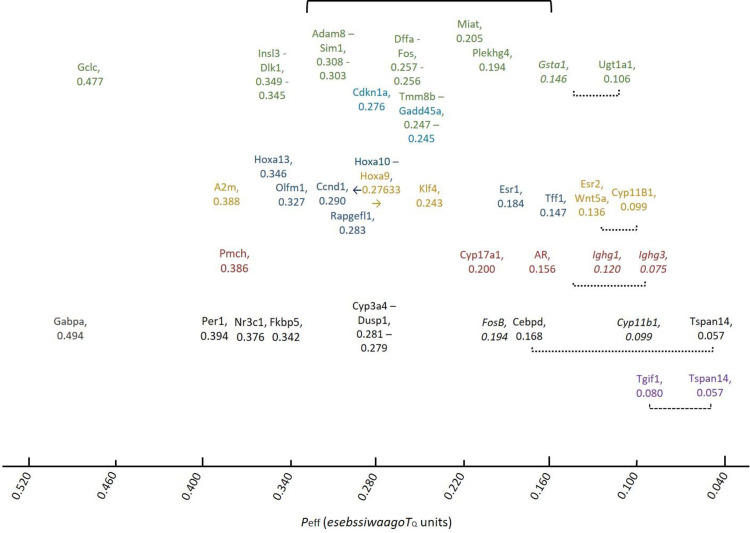
Directional alterations in cell micro-compliance by small molecule hormone ligands of steroid axis receptors and exposure-related bisphenol A and DES as high affinity inverse agonists.CORT/DEX pathway increases in duration at Peff include at 0.394 (Per1; PC12 cell, A549 lung ca), 0.342 (Fkbp5; astrocyte, neuron), Peff 0.281 (Cyp3a4)– 0.279 (Dusp1; PC12 cell, A549), Peff 0.168 (Cebpd, A549 cell) and Peff 0.057 (Tspan14, B-cell ALL) with decreases in Peff duration at 0.376 (Nr3c1, GR; A549 lung ca), Peff 0.194 (FosB, PV neuron) and Peff 0.099 (Cyp11b1; adrenal cortex, nl). The CORT/DEX pathway Δ Cmicro contraction-expansion response increase in the lower Peff interval is 0.111 from the maximum expansion interval (punctate bracket). DHT pathway increases in duration at Peff include at 0.386 (Pmch; neuroendocrine, hypothal), Peff 0.200 (Cyp17a1, 17,20-lysase; Leydig) and 0.156 (Ar, PC cell) with decreases in Peff duration at 0.120 (Ighg1; B-cell, nl) and Peff 0.075 (Ighg3). The DHT pathway Δ Cmicro contraction-expansion response increase in the lower Peff interval is 0.067 from the maximum expansion interval (punctate bracket). BPA pathway increases in duration at Peff include at 0.349 (Insl3, Leydig cell)– 0.345 (Dlk1, pre-adipocyte stromal cell), Peff 0.308 (Adam8)– 0.303 (Sim1, whole brain), Peff ≤ 0.258 (Meg3)– 0.256 (Fos, spermatocyte), Peff 0.205 (Miat) and Peff 0.194 (Plekhg4) with a decrease in duration at Peff at 0.146 (Gsta1). BPAF pathway increases in duration at Peff include at 0.276 (Cdkn1a) and 0.245 (Gadd45a). The pathway Cmicro contraction-expansion response increase in the lower Peff interval is ≥ 0.040 from the maximum expansion interval (punctate bracket) for bisphenol A (BPA, intracellular) and bisphenol AF (BPAF, extracellular). DES pathway increases in duration at Peff include at 0388 (A2m), 0.27633 (Hoxa9, uterine), 0.243 (Klf4) and 0.136 (Wnt5a, Esr2) with decreases in duration at Peff 0.27630 (Hoxa10, uterine) and Peff 0.332 (Hoxa11). The DES pathway upwards shift in Cmicro contraction is to Peff 0.1359–0.1361 (Wnt5a, Esr2) with response expansion to ~0.099 (Cyp11b1) [(+) upward shift Δ Cmicro contraction with maxima expansion pathway] In comparison, Estradiol (E2) pathway increases in duration at Peff include at 0.290 (Ccnd1; MCF-7 cell), Peff 0.147 (Tff1, pS2; MCF), with decreases in Peff duration at 0.136 (Esr2, skeletocyte). The E2 pathway results in downward shift Cmicro contraction is a Peff 0.14703 (Tff1) and a Peff setpoint lower with minimal expansion [(-) downward shift Δ Cmicro contraction with minima expansion pathway]. black text, dexamethasone (Dex)/corticosterone common GR receptor pathway; magenta brown text, dihydroxytestosterone (Dht) AR receptor pathway; blue text, estradiol (E2) ER receptor pathway; green text, intracellular bisphenol inverse agonist pathway; teal text, extracellular bisphenol pathway; gold text, diethylstilbesterol (DES) ER receptor pathway; italics text, decreases in Peff duration at activation or increases in repression duration at Peff (2ndary); solid black bracket, max contraction interval during increase in duration at Peff (co-, ortho-planar PCB std); dotted brackets, lower Peff expansion intervals; dashed brackets, lower limit range of Peff expansion interval.